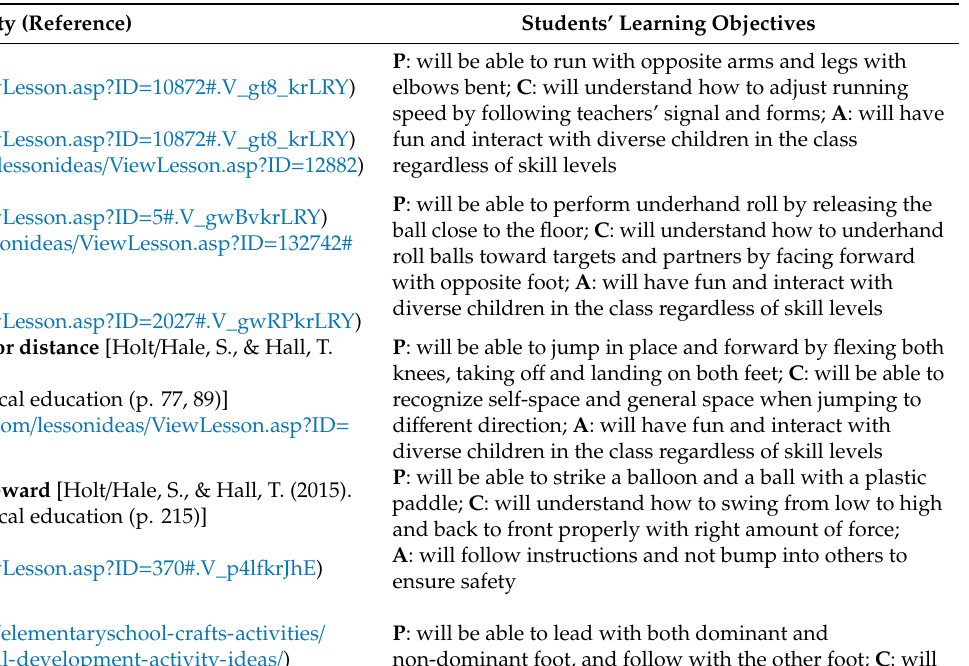
Table A1. Twenty-four lessons for structured fundamental motor skill-focused afterschool